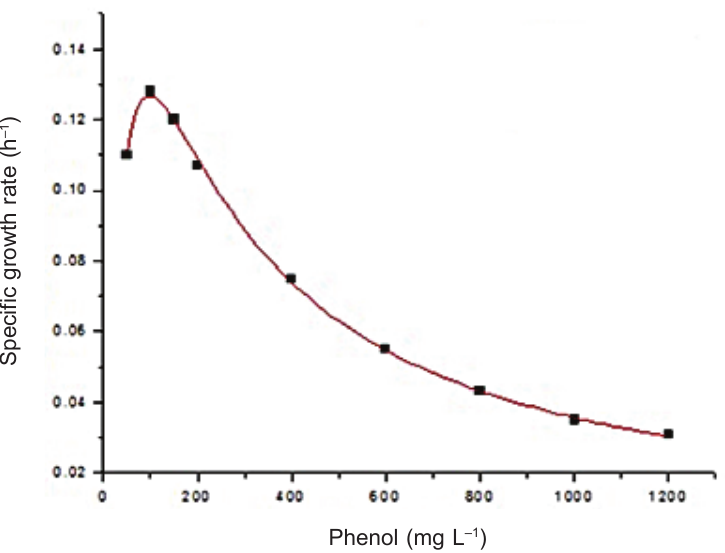
Fig. 8 – Experimental and predicted specific growth rates of the culture according to Haldane’s model